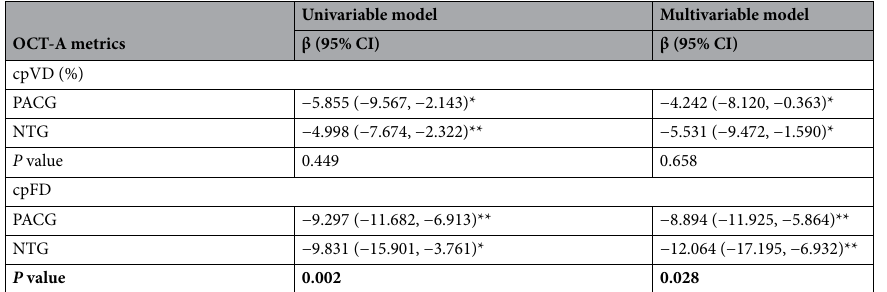
Table 5. Comparison of regression coefficients of OCT-A metrics with average RNFL thickness between PACG and NTG. Significant values are in bold. cpVD = circumpapillary vessel density; cpFD = circumpapillary fractal dimension; PACG = primary angle closure glaucoma; NTG = normal tension glaucoma; RNFL = retinal nerve fiber layer; β = regression coefficient; CI = confidence interval. *Denotes P < 0.05; **denotes P < 0.001; OCT-A metrics were analyzed as per SD decrease. Multivariable regressions were adjusted for age, sex, spherical equivalent, intraocular pressure, number of glaucoma medications and OCT-A image quality score.